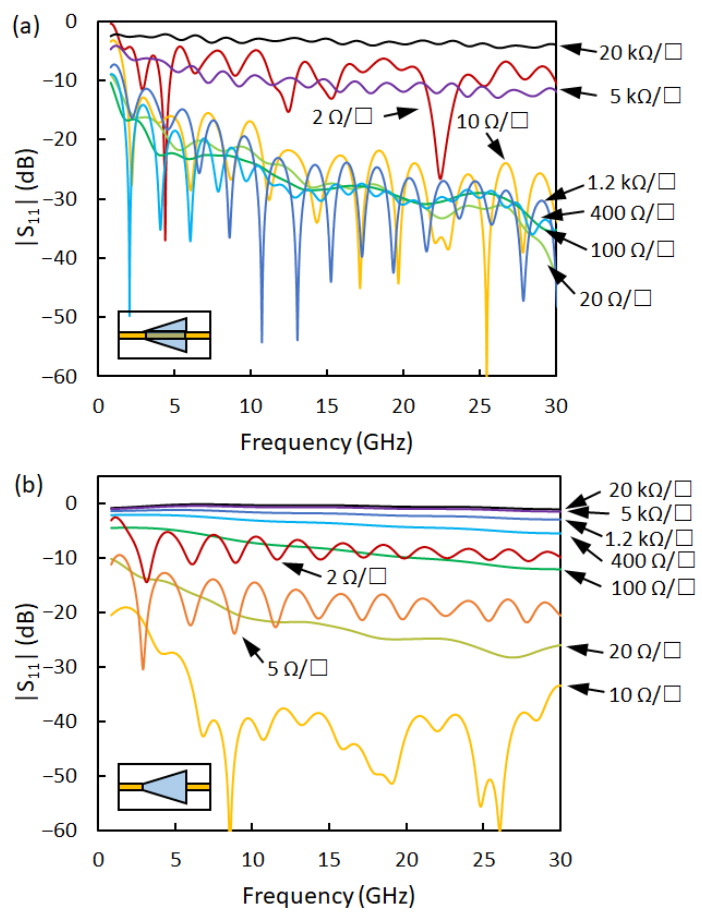
Figure 3. The S-parameters of the laser-scribed terminations with a series of sheet resistances of rGO film in the case of ( a ) an overlapped structure with copper strip conductors in the center, and ( b ) a design without copper strip conductors.